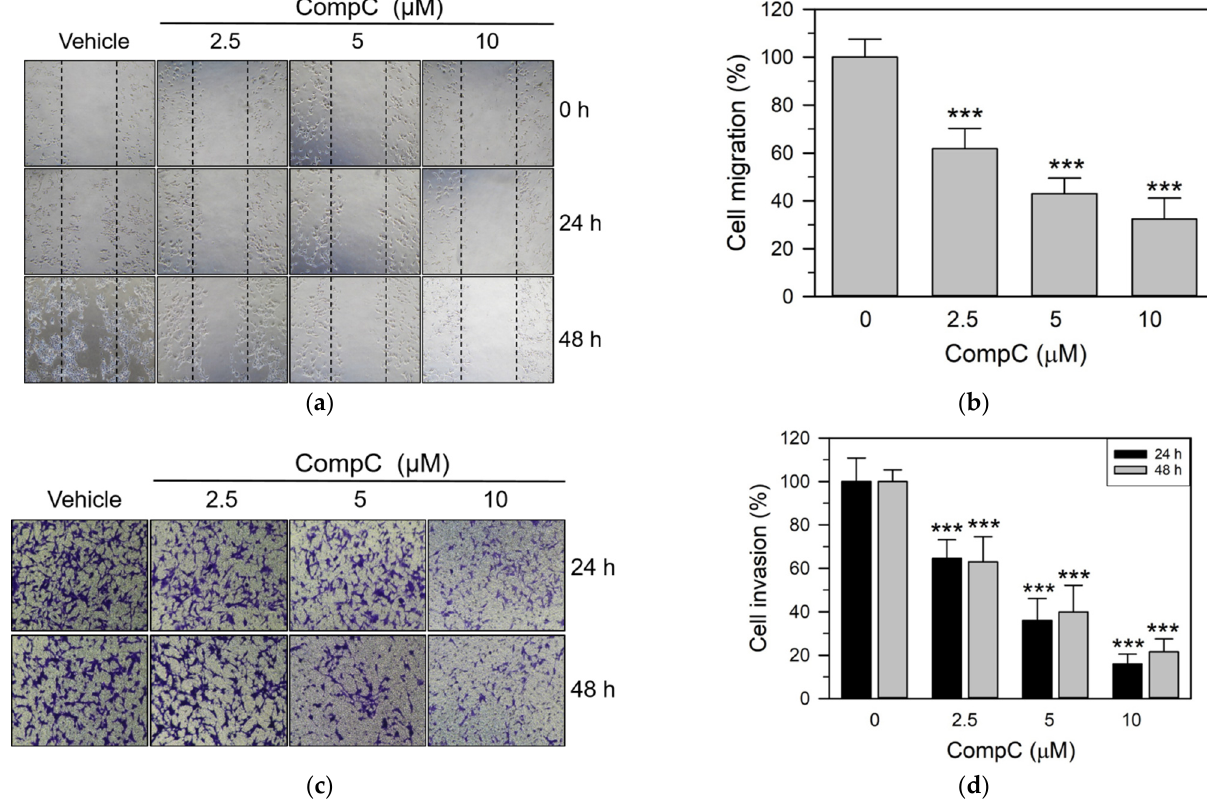
Figure 7. CompC inhibited the migration and invasion of Renca cells. ( a , b ) Cell migration was assessed based on the wound healing assay that counts the number of cells to move into an acellular area. Cells (1 × 10 5 ) seeded onto a 6-cm dish and grown in culture media were serum-starved for one day in SFM and denuded in a few areas. Cells were then incubated for 24–48 h in FBS culture medium with the vehicle or various concentrations of CompC. Photographs of Renca cells were taken at 24 h and 48 h ( a ), while the number of Renca cells that had migrated into the acellular area was counted and plotted in ( b ). ( c ) Cell invasion was assayed using the SPLInsert TM Matrigel Transwell invasion assay kit. Cells (1 × 10 5 ) were suspended in the SFM medium containing DMSO or 2.5–10 μ M CompC and carefully transferred into the upper chamber of the devices. Cells that had invaded the polycarbonate membrane to the lower surface for 24–48 h at 37 °C were fixed, stained with crystal violet, and photographed by a light microscope (100×). ( d ) The stained cells were quantified using the ImageJ software. Three independent experimental results were presented as the percentage of cell invasion relative to the vehicle-treated control. *** p < 0.001, compared with the vehicle-treated control.